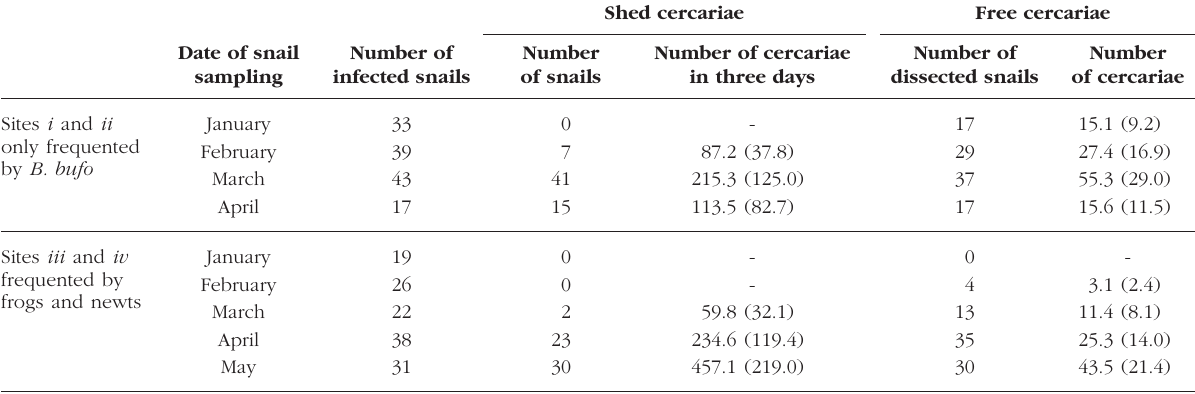
Table II. – Mean numbers (S.D.) of H. cylindreacea cercariae shed by infected snails or counted in snails after their dissection. Individual values recorded for each parameter between 2001 and 2009 were pooled and were expressed for a single year.